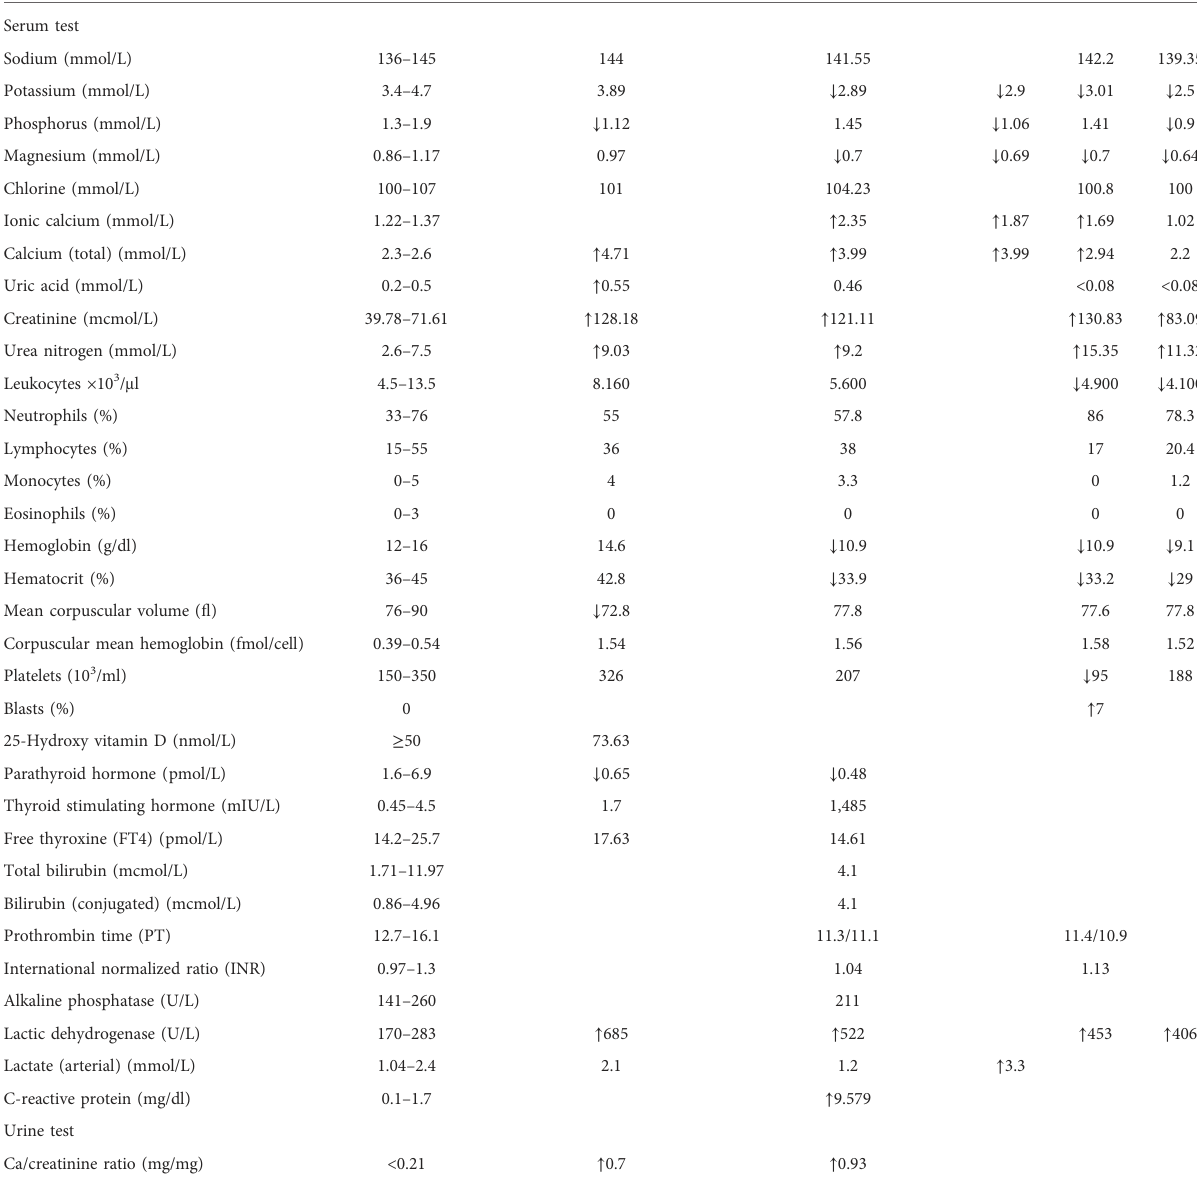
TABLE 1 Laboratory tests over time. Blood